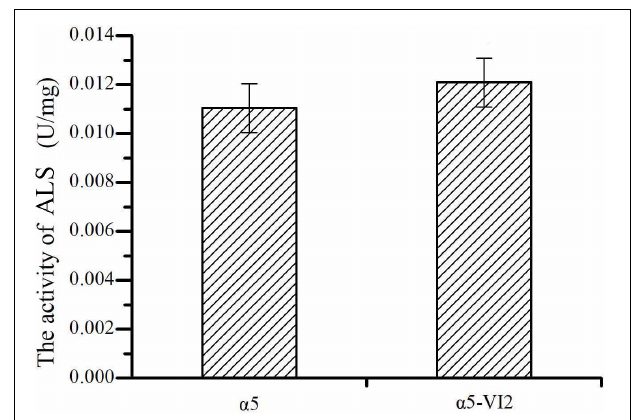
FIGURE 4 | The activities of α -acetolactate synthase (ALS). Data represent the mean of three independent biological replicates. Error bars represent the SD of the average